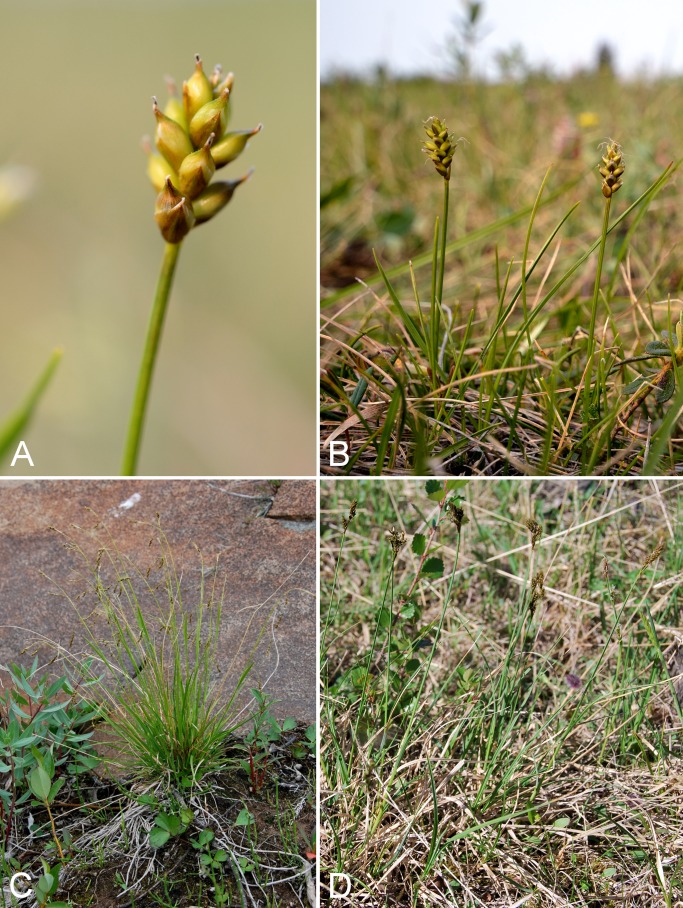
Carex gynocrates, Carex krausei, and Carex lachenalii.Carex gynocrates: (A) inflorescence, Saarela et al. 3276. (B) Habit, Saarela et al. 3276. Carex krausei: (C) habit, Saarela et al. 3856. Carex lachenalii: (D) habit, vicinity of Fockler Creek, Nunavut, 2 July 2014. Photographs by R. D. Bull (A, B) and J. M. Saarela (C, D).